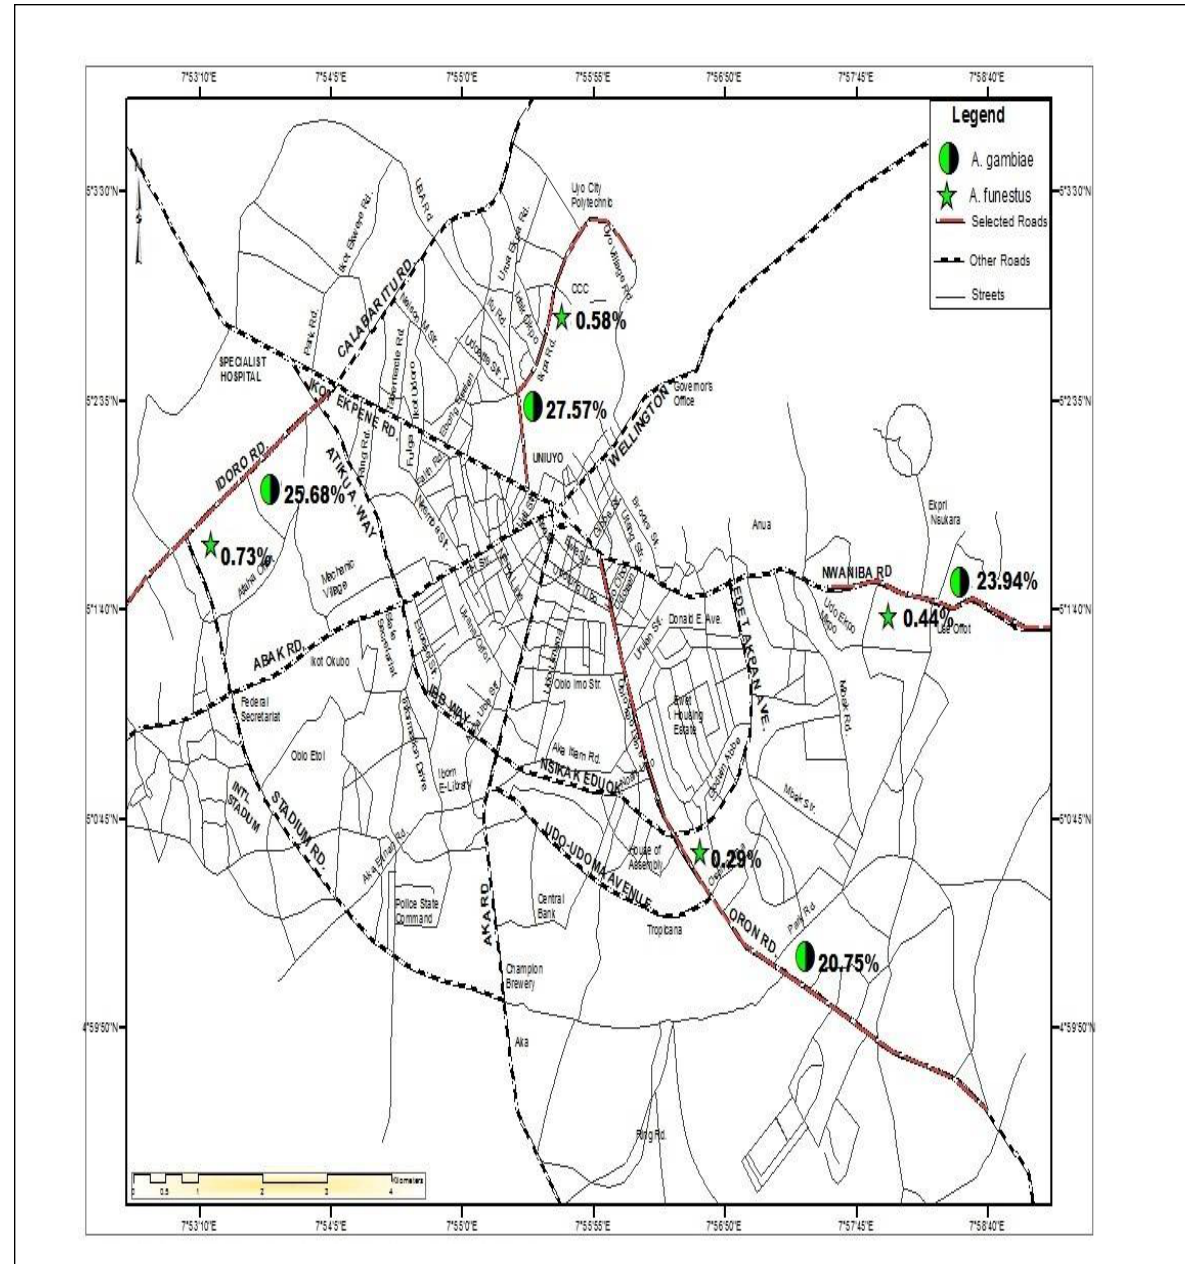
Figure 1: Map of Uyo metropolis showing study area (Source: GIS Unit, University of